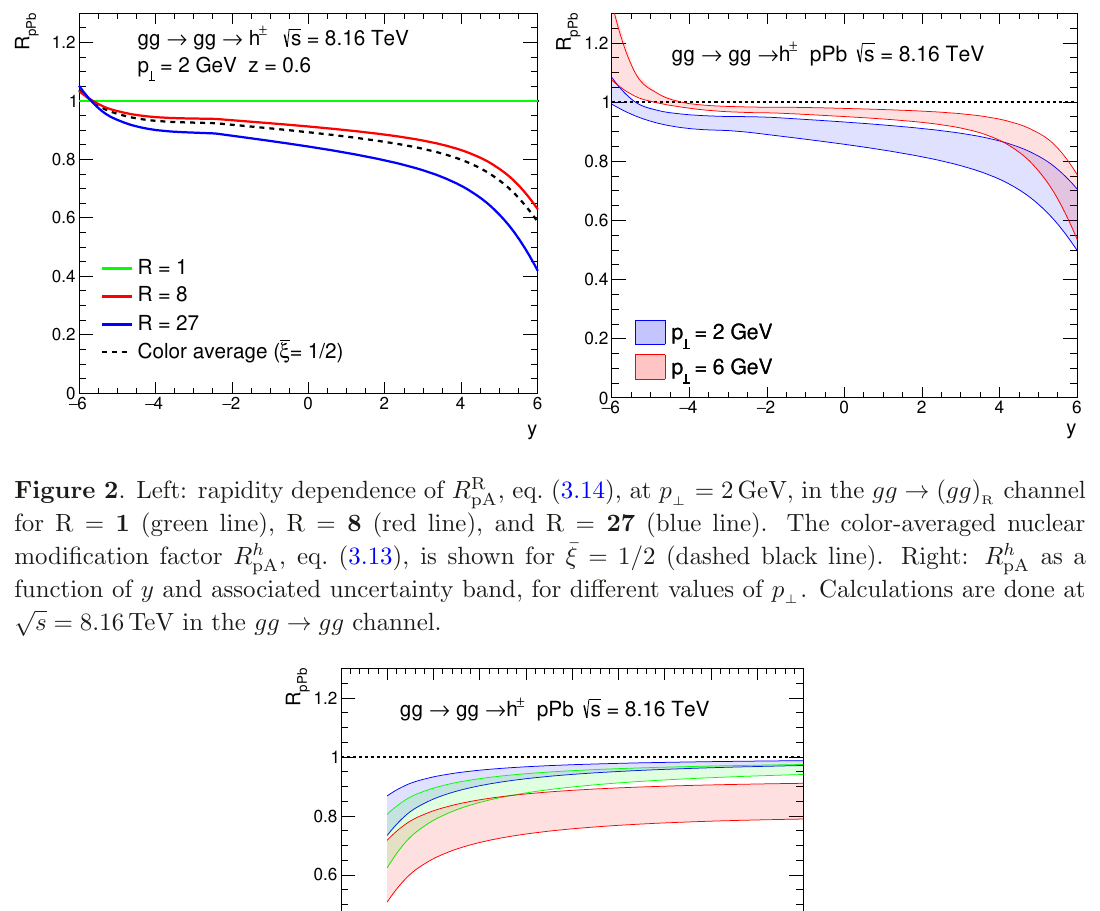
Figure 3 . Nuclear modi(cid:12)cation factor (3.13) as a function of p tions are done at p s = 8 : 16 TeV in the gg